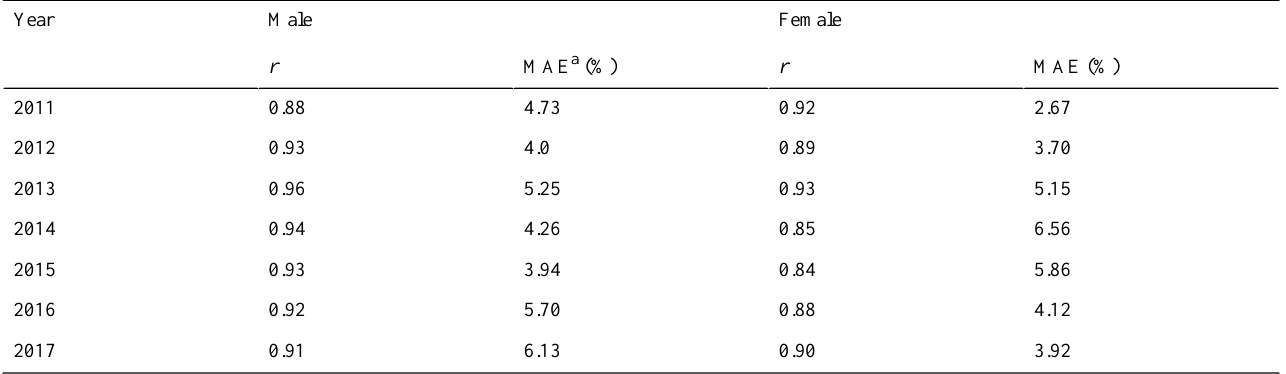
Table 4. Subgroup (gender) prediction performance for gonorrhea. P <.001 for all r values. FemaleMaleYear